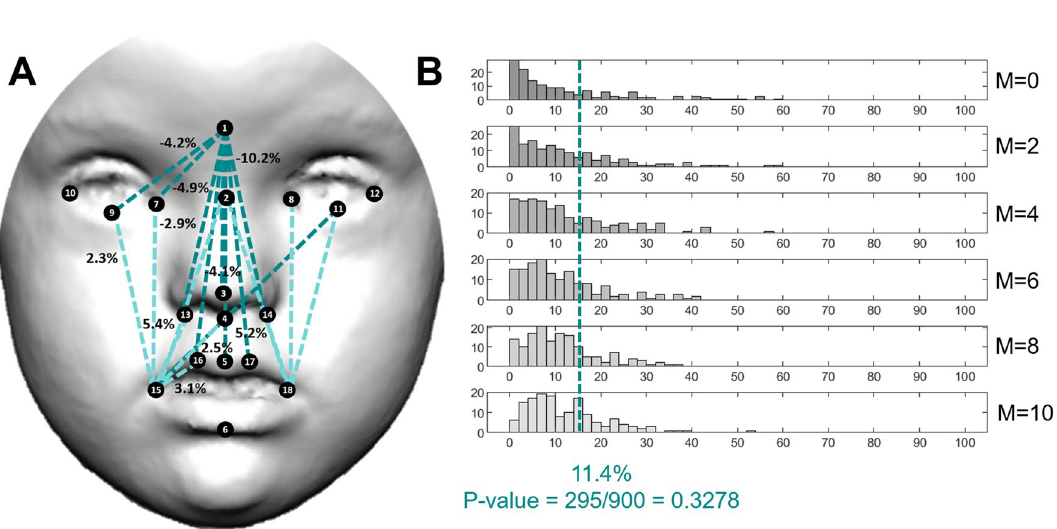
Figure 5. Localized Euclidean Distance Matrix Analysis facial shape pairwise contrasts and iterative bootstrapping tests of facial dysmorphology between controls and individuals diagnosed with Neurofibromatosis type 1. From top to bottom histograms, the simulations included 0, 2, 4, 6, 8 and 10 patients. For more details see legend Fig. pattern associated with NF1 is so subtle that overall is not larger than facial differences that could be randomly detected using a sample of control subjects. For the other syndromes, the simulation tests confirmed that the facial dysmorphologies associated with Down, Morquio and Noonan syndromes were significant and different from random comparisons in control subjects. Few simulations resulted in a higher FDS than the FDS obtained with the complete real sample (Figs. 2B, 3B, 4B, first row and blue line). Moreover, in DS, MS and NS, facial dysmorphology scores increased as larger numbers of diagnosed individuals were included in the simulations (Figs. 2B, 3B, 4B, middle rows), confirming the severity of the facial dysmorphologies associated to these syndromes. Finally, the simulations comparing all recruited diagnosed individuals (last row) with random subsamples of control subjects (first row) indicated that FDS scores can range widely from 10 to 80%, underscoring the biasing effects of small sample sizes. Face2Gene accuracy in Colombian and European populations.